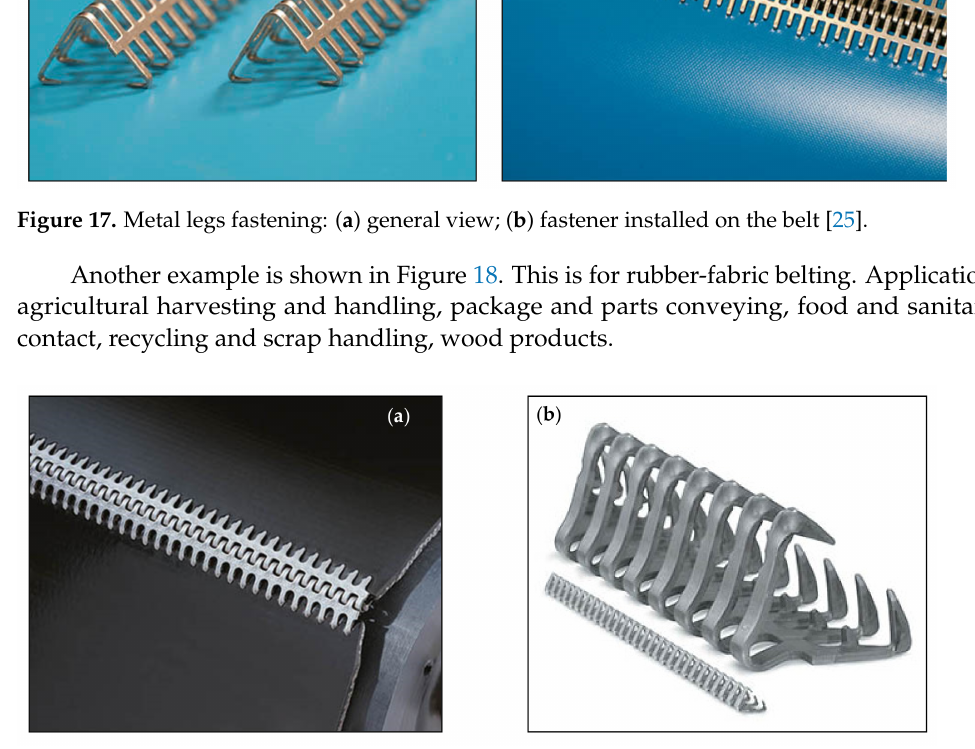
Figure 18. Metal legs fastening: ( a ) general view on the belt; ( b ) single string of fasteners